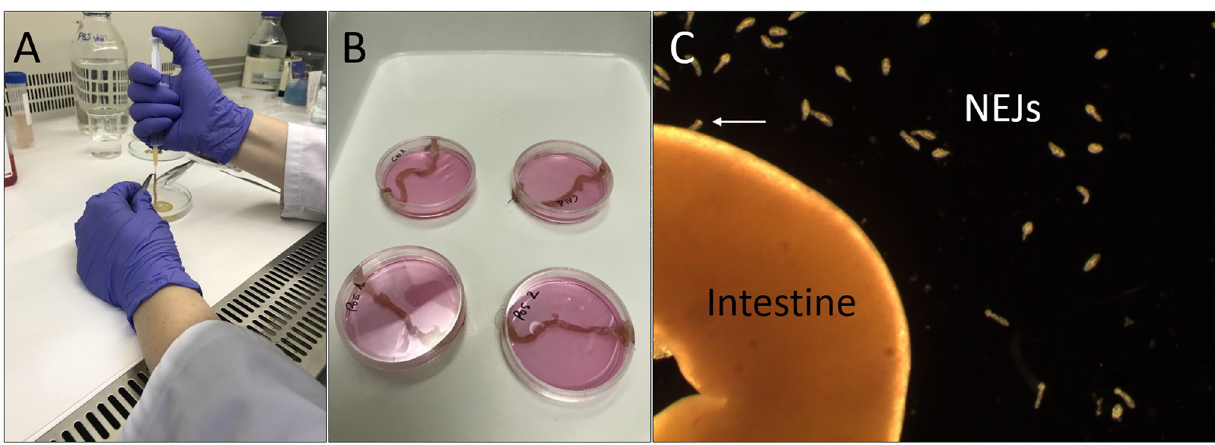
Fig 1. Ex vivo model for the migration of FhNEJ through mouse intestine. A) Preparation of the intestines before FhNEJ infection; B) Incubation of ligated intestines in RPMI medium at 39˚C 5%CO 2 for 2.5 h; C) Image obtained in a stereomicroscope showing the FhNEJ after intestinal passage (white